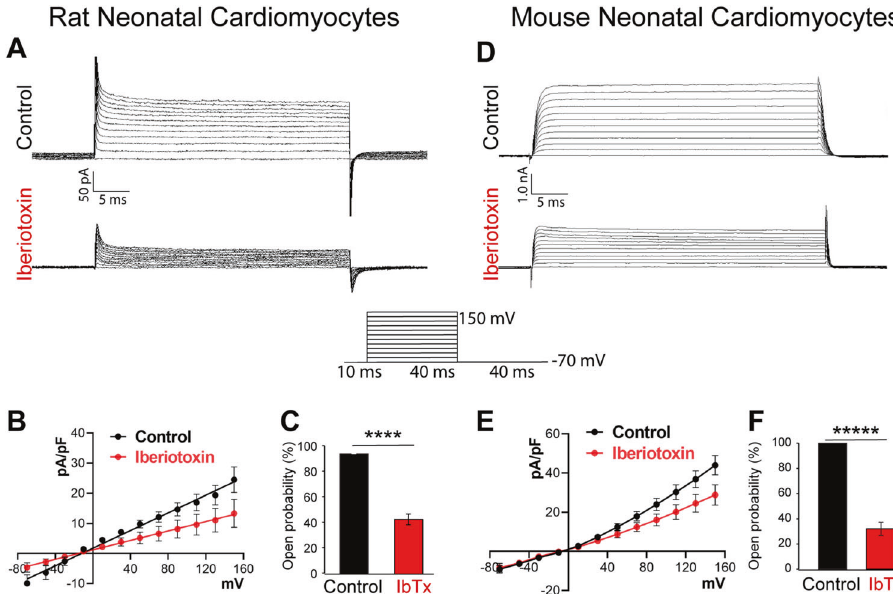
Fig. 2 Rodent neonatal cardiomyocytes express functional BK Ca channels. Traces of whole-cell BK Ca channel currents were recorded from A rat neonatal cardiomyocytes and D mouse neonatal cardiomyocytes with or without iberiotoxin (100 nM). Neonatal cardiomyocytes B rat and E mouse, membrane currents were activated by 40 ms voltage steps of 20 mV between − 70 to + 150 mV from resting − 70 mV holding potential. The current versus voltage relationships are plotted with or without iberiotoxin. C and F Percentage block of BK Ca current in the presence or absence of iberiotoxin. Cells were isolated from ten independent litters from mice and rats, and data are represented as mean ± SEM. P -values were determined by a one-tailed paired student ’ s t -test; **** ≤ 0.00001, ***** ≤